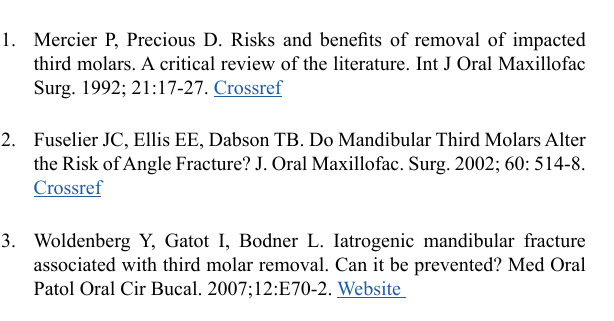
Table 3: The disposition of the treatment rendered Complication Leave alone Dental caries Chronic pericoronitis Lower 3rd molar periodontal pocket